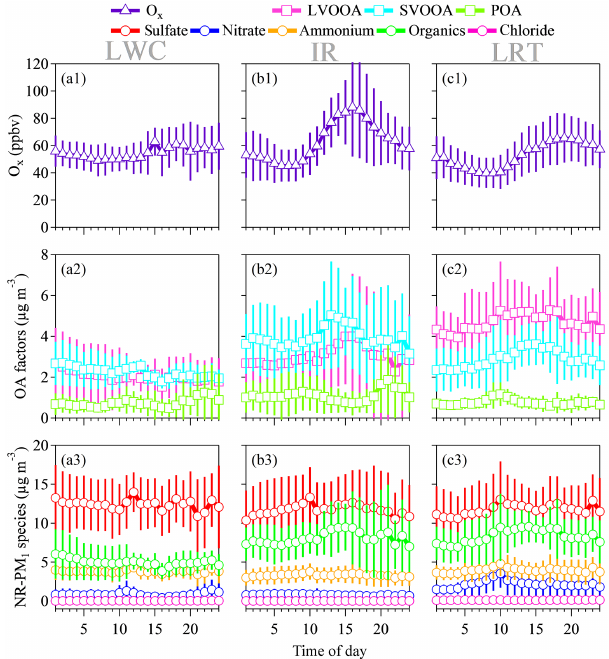
Figure 2. Summary of diurnal variations of the PM 1 species, PMF- resolved organics and O x in the three types of episodes. Means are shown as points and standard deviations as error